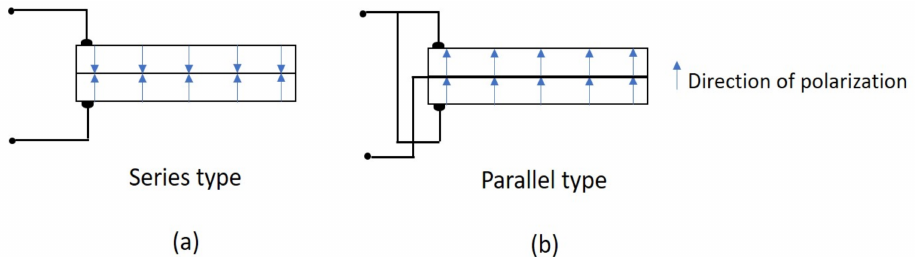
Figure 2. Piezoelectric ceramic transducers: ( a ) series type; ( b ) parallel type.